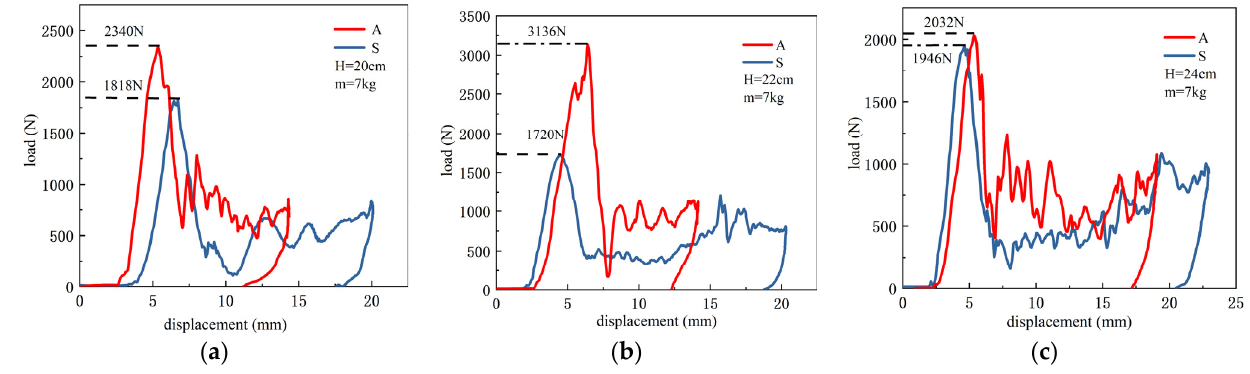
Figure 13. Load–displacement curve during the dynamic compression tests at different drop heights ( H ), H = 20 cm ( a ); H = 22 cm ( b ); H = 24 cm ( c ), (S denotes uniformly filled specimen, and A denotes adaptive-density-filled specimen) .